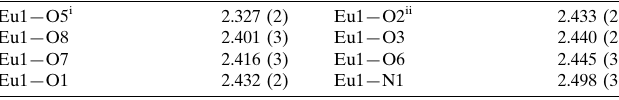
Selected bond lengths (A˚ ).